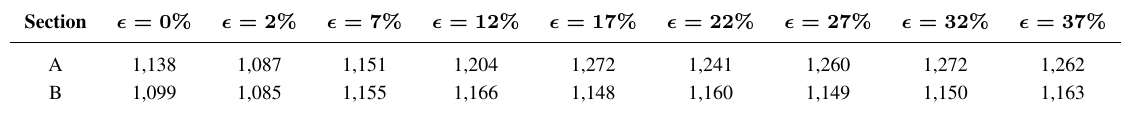
Table 2. Aspect ratios for SFF 100 in section A and